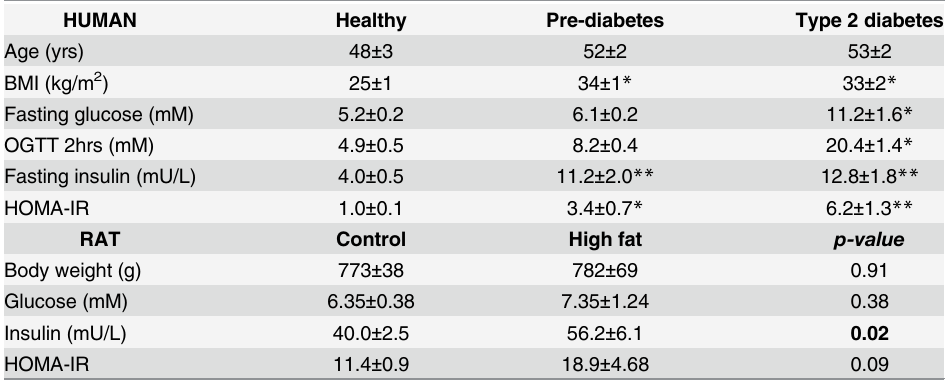
Table 1. Phenotypic characteristics. HUMAN